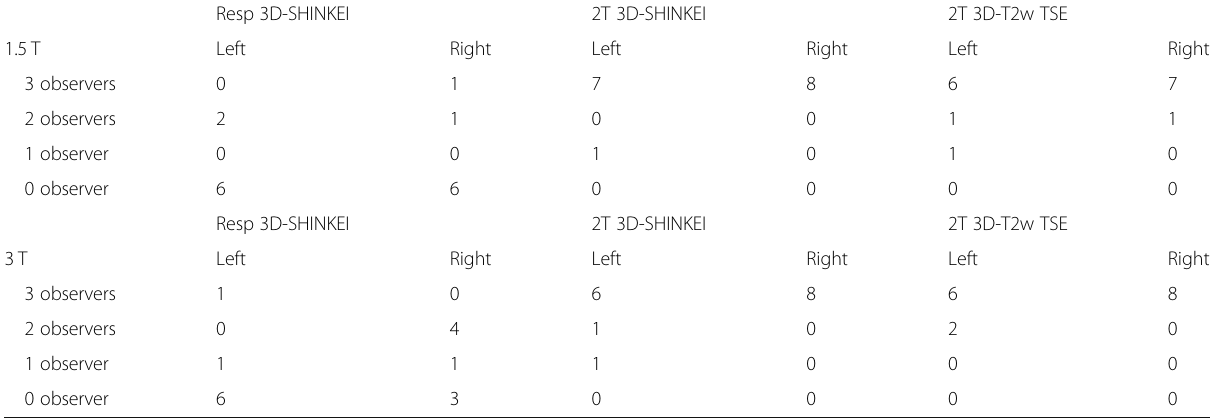
Table 2 Visibility of the left and right ganglion per sequence and field strength. 2T refers to the double respiratory and cardiac